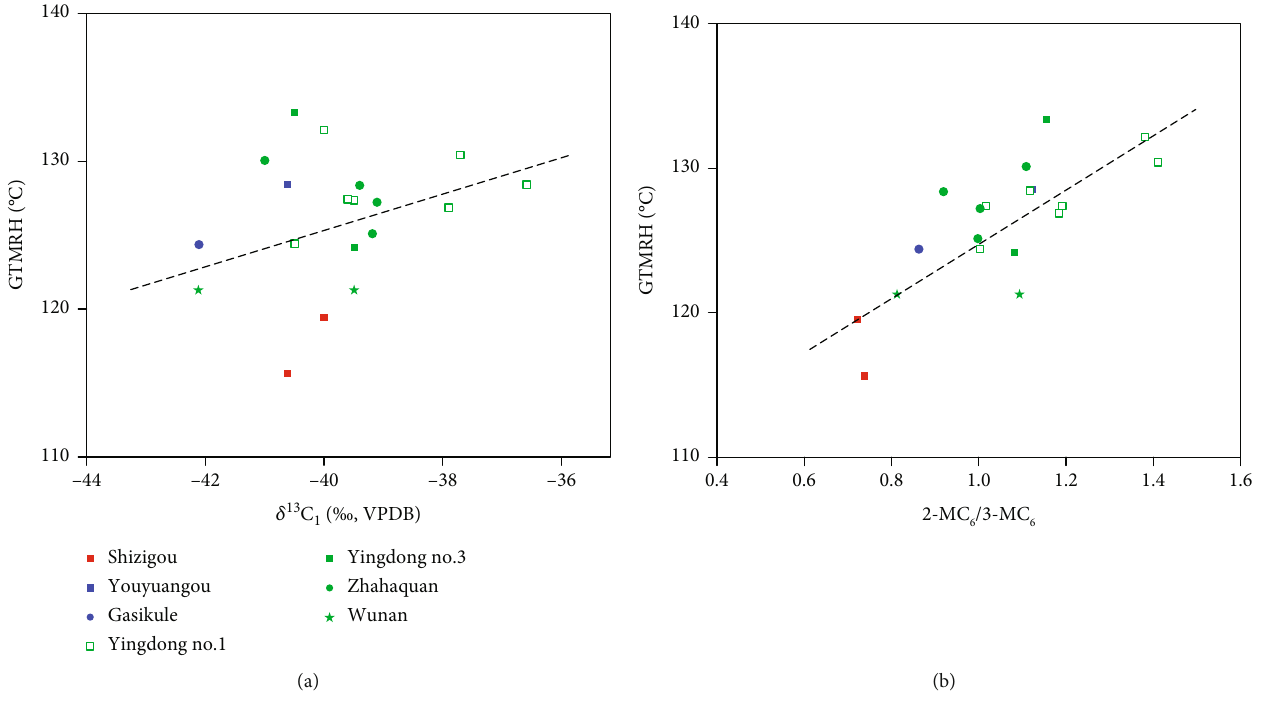
Figure 7: Cross plots of (a) GTMRH vs. δ 13 C